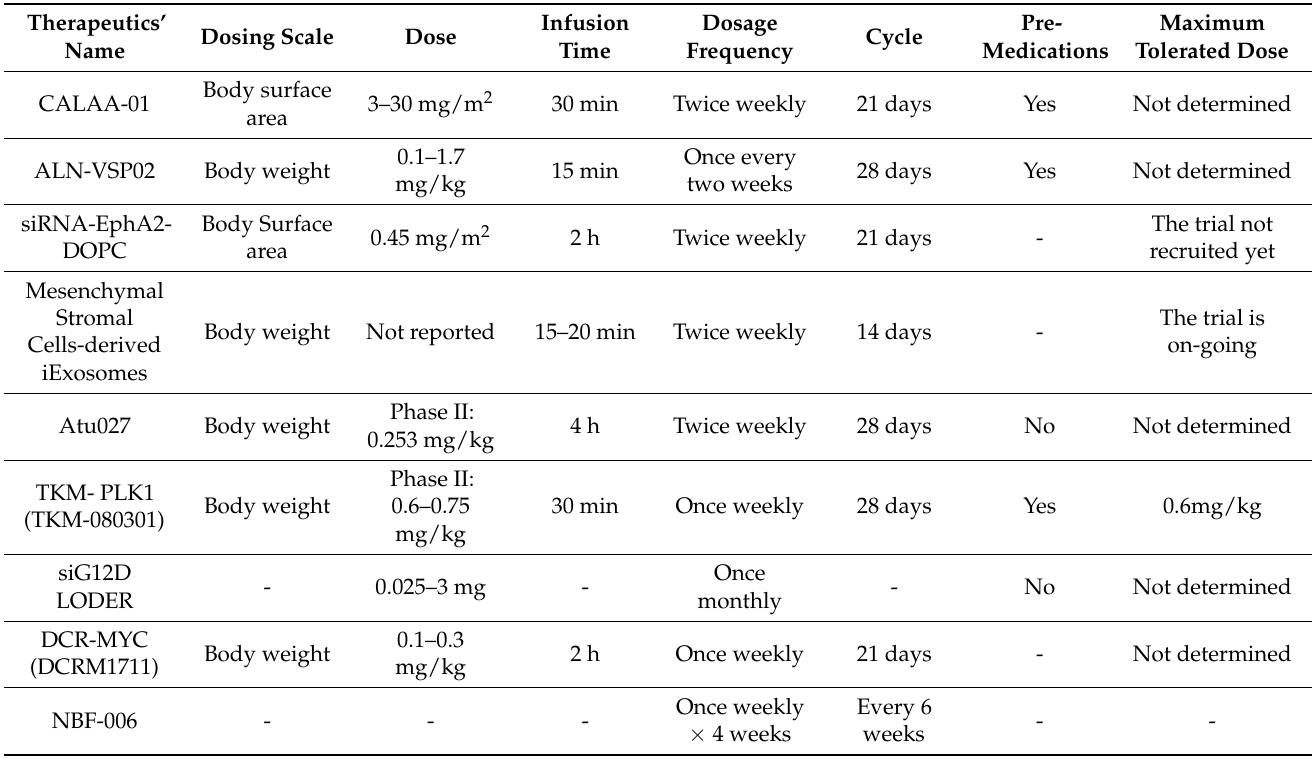
Table 3. Dosage schedule for the clinically investigated anticancer siRNA nanotherapeutics.